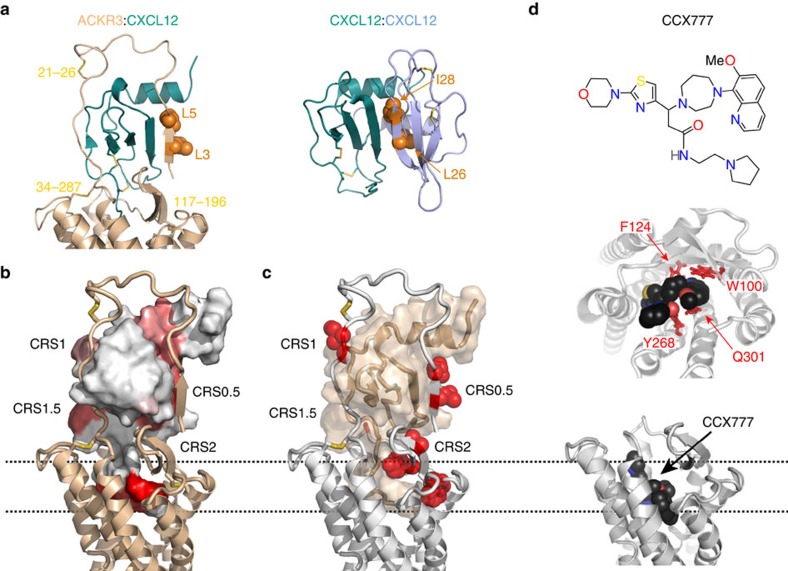
Ligand interactions in ACKR3 complexes.(a) The CRS0.5 interaction mimics the CXCL12 dimerization interface (PDB ID: 2k01)30. Side chains of homologous residues in ACKR3 (L3 and L5) and the second CXCL12 protomer (L26 and I28) are highlighted as orange spheres. (b) ACKR3:CXCL12 complex with the chemokine coloured shades of red according to protection in the ACKR3:CXCL12 complex as determined from radiolytic footprinting experiments. Darker red colour corresponds to stronger protection (see Fig. 3a). (c) Same complex as in (b). Side chains of receptor residues that are protected in the ACKR3:CXCL12 complex relative to the ACKR3:CCX777 complex (see Fig. 4a,b) are shown as red spheres. (d) Side and top views of the extracellular region of the ACKR3:CCX777 complex with CCX777 shown in black. Side chains of residues where mutation affects CCX777-induced β-arrestin-2 recruitment are shown as red sticks.